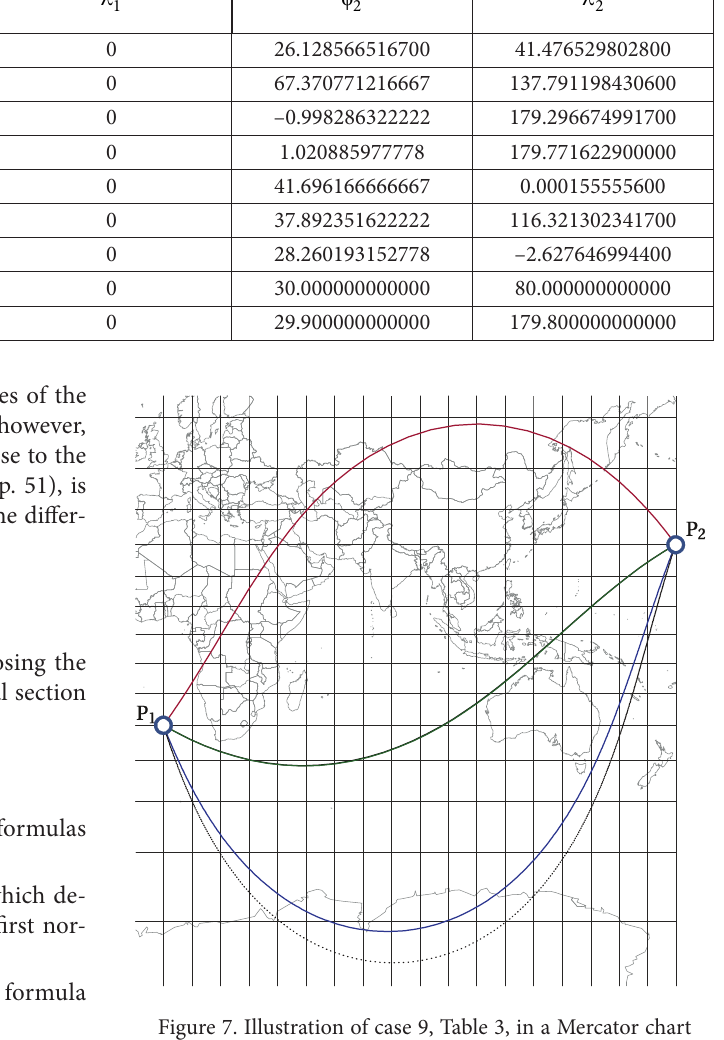
Table 2. Test cases: 1 to 7 are extracted from Gilbertson (2012, p. 3), 8 is the example of Figure 2 and case 9 is an example with points near the antipodes, extracted from Karney (2013, p. 51) Case